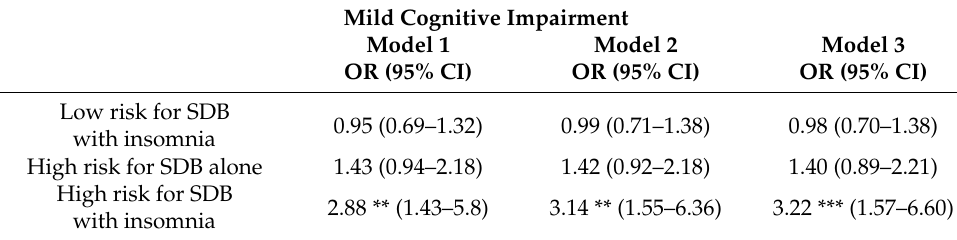
Table 2. Associations between sleep disorder groups and MCI with low risk for SDB alone as reference.